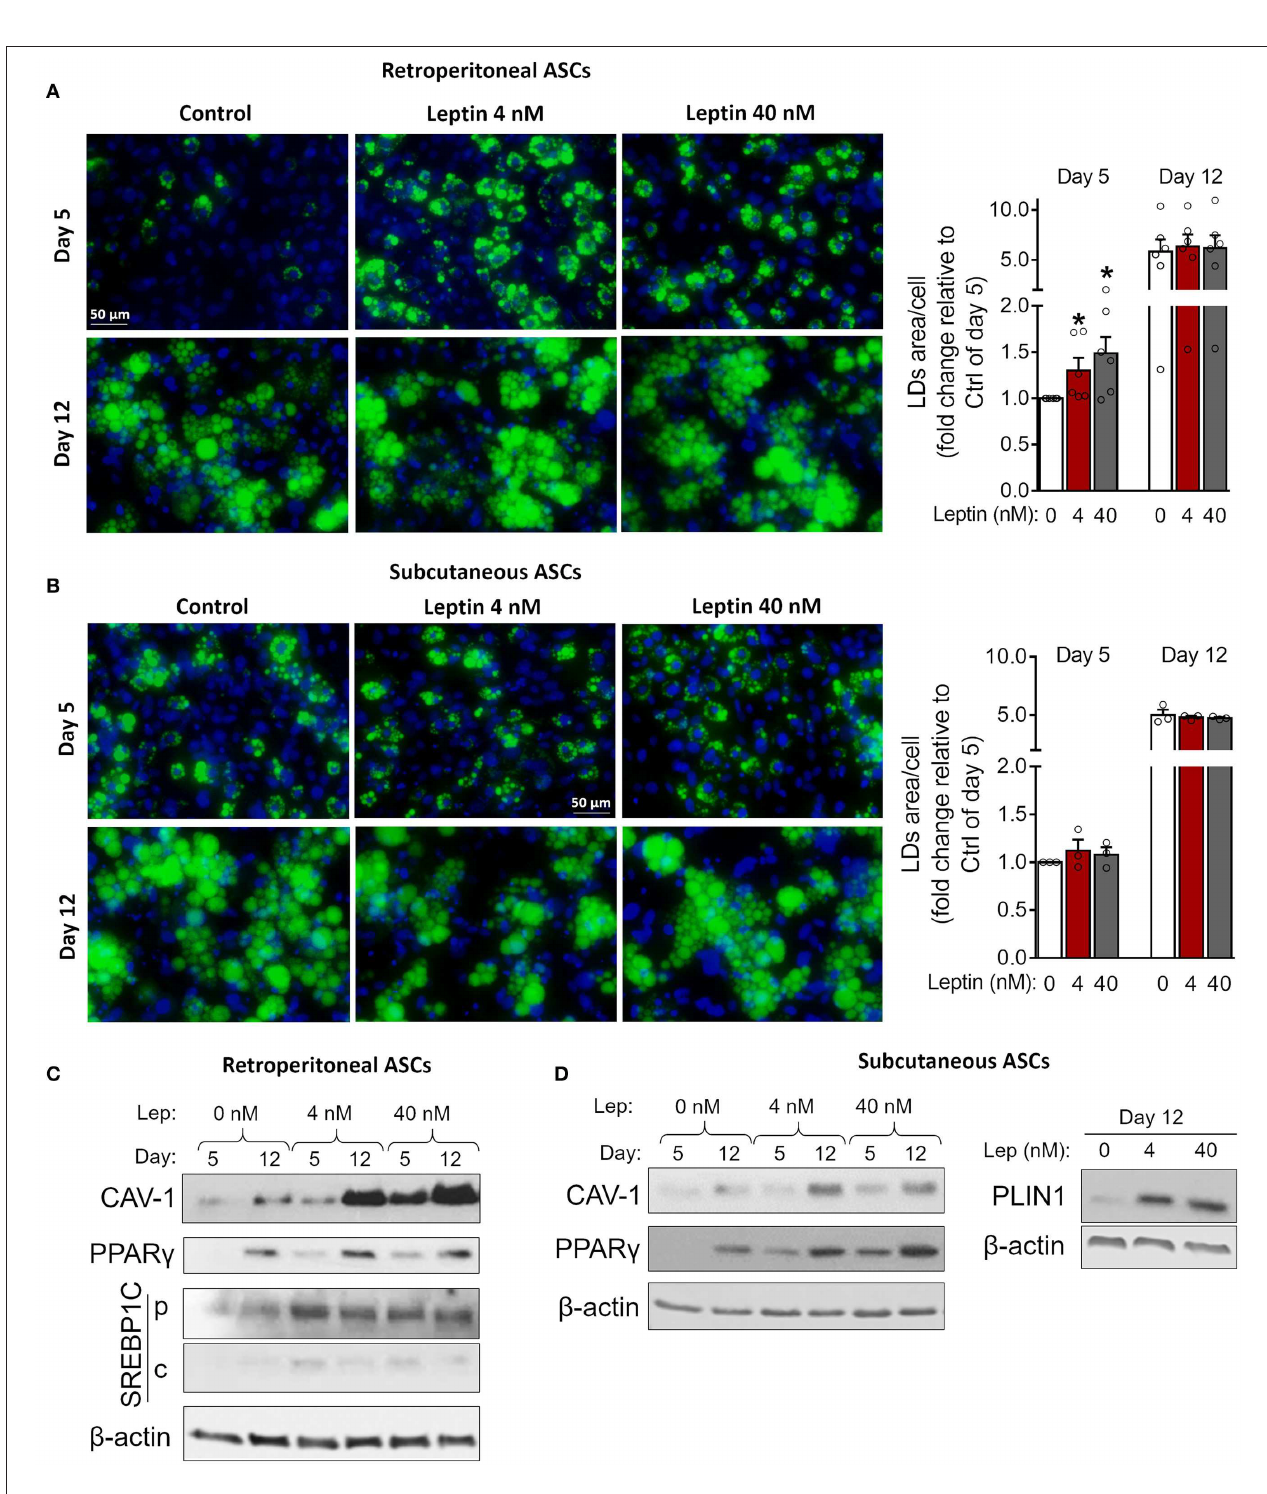
FIGURE 5 | Leptin potentiates insulin-induced adipogenesis in ASCs. Adipose-derived stem cells from subcutaneous and retroperitoneal depots were isolated and then differentiated with insulin alone or insulin plus leptin (4 or 40nM). (A,B) Fluorescence images of ASCs from (A) retroperitoneal and (B) subcutaneous depots that were differentiated into adipocytes and stained with Bodipy (green) for lipid droplets and with DAPI (blue) for nuclei. Images are representative of 3–6 independent experiments. Scale bar represents 50 µ m. Graphs show the quantification of the green area per cell relative to the control group (insulin only) at day 5. Bars represent mean ± standard error of the mean of 3–5 independent experiments. * p < 0.05 relative to the control group of the same day. Statistical analyzes were performed by using Kolmogorov-Smirnov test. (C,D) Western blot analysis of CAV-1 and PPAR γ and β -actin in ASCs differentiated at the conditions specified. Blots are representative of 3–5 independent